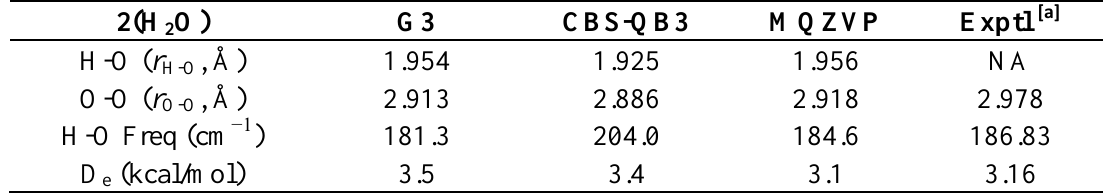
) of water dimer benchmark e